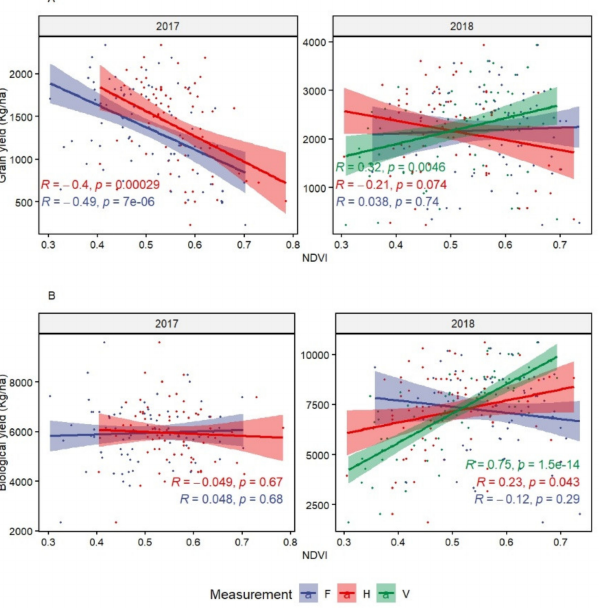
Figure 6. Linear regression and the Pearson correlation coefficient of normalized difference vegetation index (NDVI) measured at vegetative stage (V), heading (H), and grain filling (F) versus grain yield ( A ) and biological yield ( B ) under continuous heat stress during two seasons (2016–2017 and